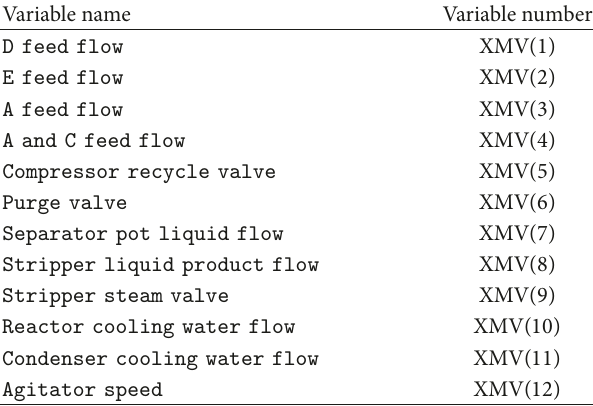
Table 1: Process manipulated variables.